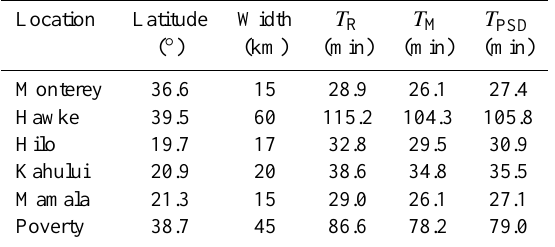
Table 4. Estimates of shelf-resonance periods. T R is a solution to (cid:16) (cid:17) L = gα/ ω 2 − f 2 , where L is the shelf width, g the gravita- tional acceleration, α the shelf slope, ω the frequency of oscilla- tion, and f the Coriolis parameter. The shelf slope is estimated as break depth/width where we assume a break depth of 300m. T M is √ gd for an open basin, where d from Merian’s formula T M = 4 L/ is the basin depth which we assume to be one-half the shelf break depth. T PSD are values from the power spectral density estimates from shelf-mode frequencies marked with triangles in Fig.